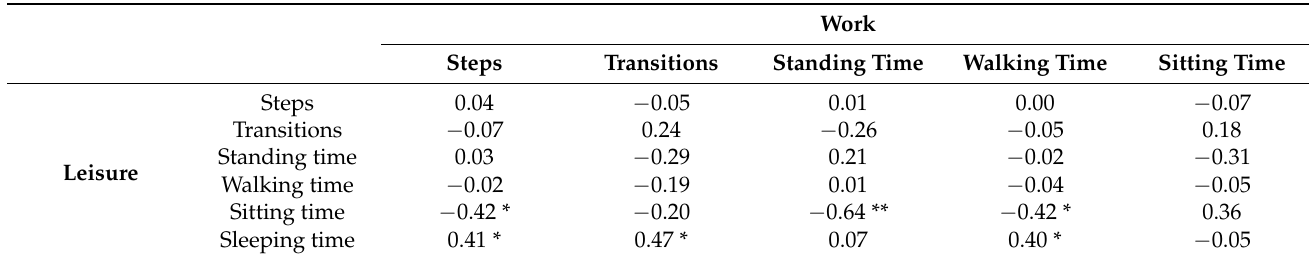
Table 5. Spearman correlations between the time spent standing, sitting, and walking during work and leisure time.